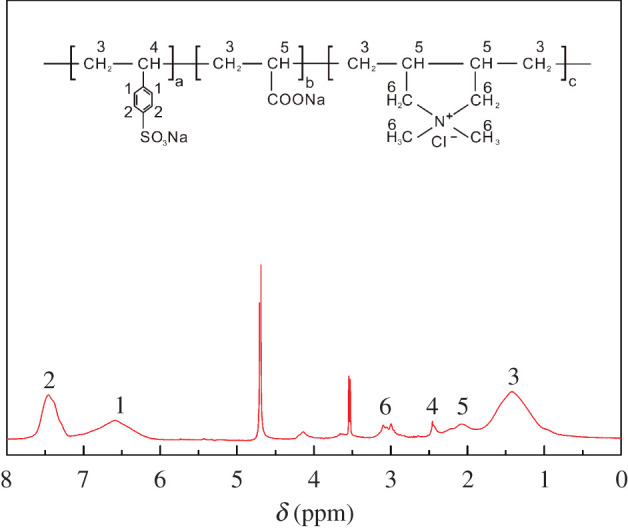
1H NMR spectrum of P(SS-co-AA-co-DMDAAC).